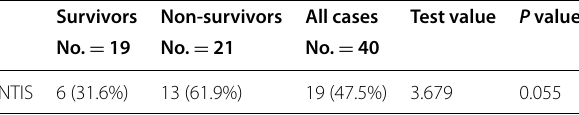
Table 5 NTIS among survivors and non survivors